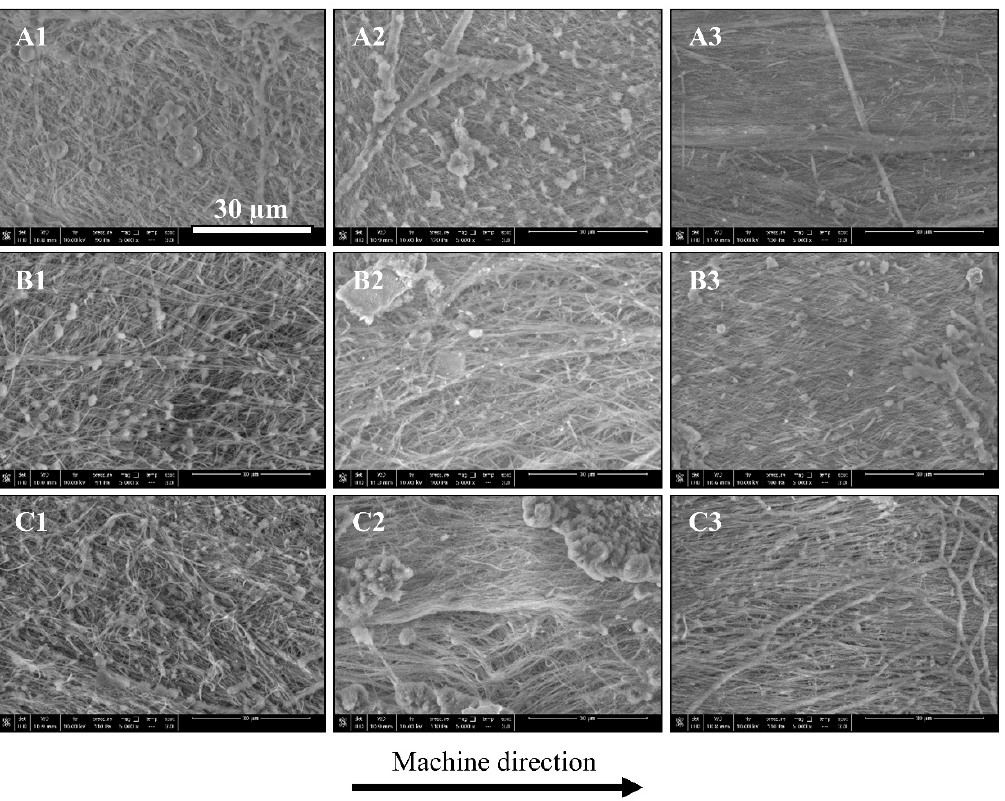
Figure 5. SEM images showing PET nanofiber orientation along the machine direction (MD). ( A – C ) denote PET concentrations of 3, 7, and 15 wt.% respectively. 1, 2, and 3 denote low extreme, intermediate, and high extreme processing conditions, respectively. All images were taken at 5000× magnification.